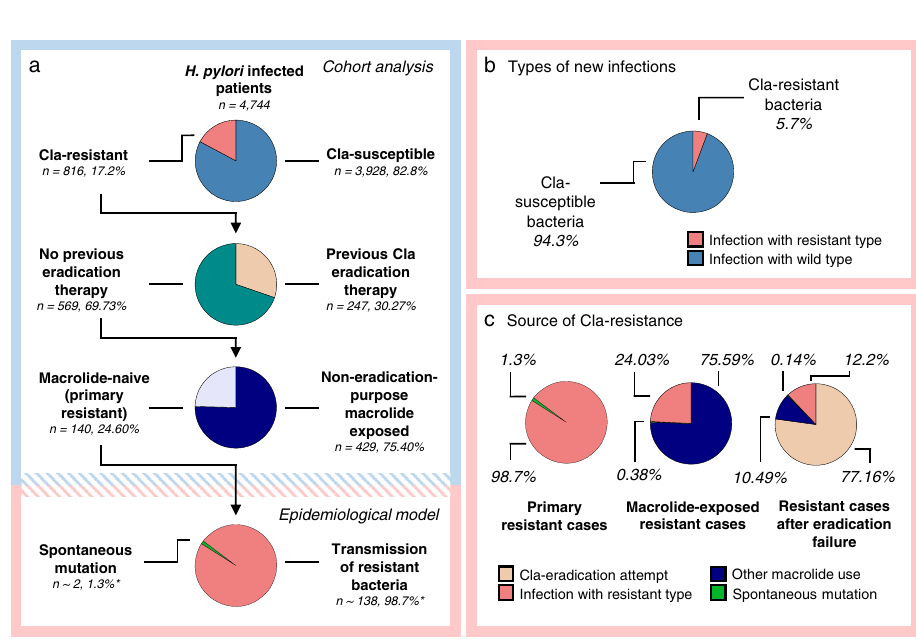
Fig. 3 Population dynamics of clarithromycin resistant H. pylori . The results of the retrospective cohort analysis are framed in light blue. The conclusions of the constructed epidemiological model are framed in light red. a Source of Cla-res in primary and secondary clarithromycin-resistant infections. Secondary resistance cases were divided according to their anamnestic drug exposure (prior clarithromycin-containing